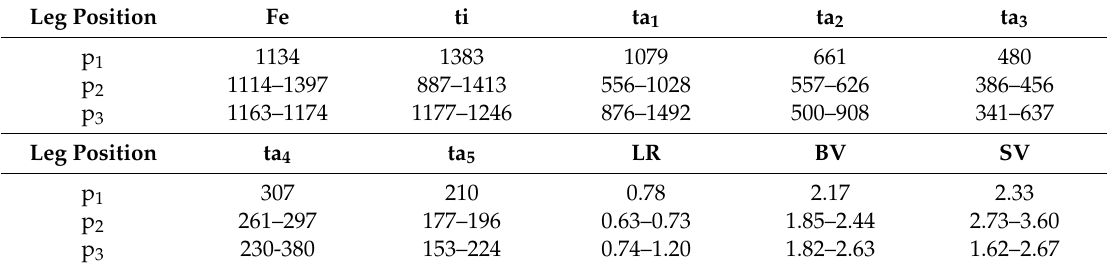
Table 5. Lengths (in µ m) and proportions of leg segments for Ablabesmyia monilis (Linnaeus, 1758) (n = 1–2). Leg Position Fe ti ta 1 ta